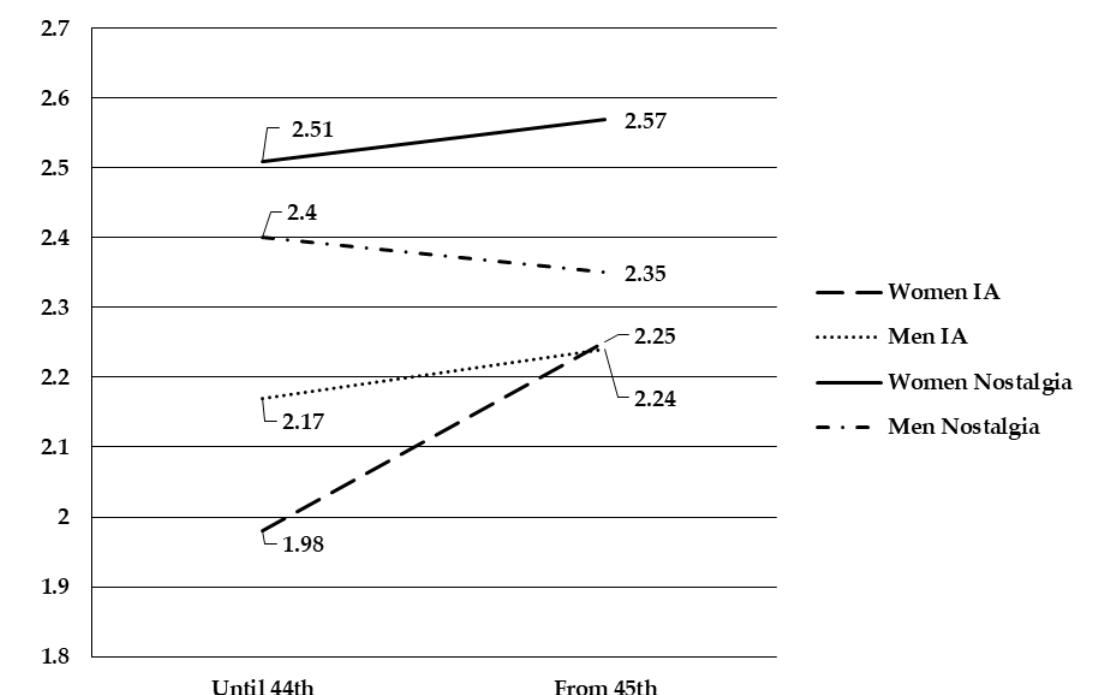
Figure 2. Interaction effects between sex and confinement in IA and nostalgia.